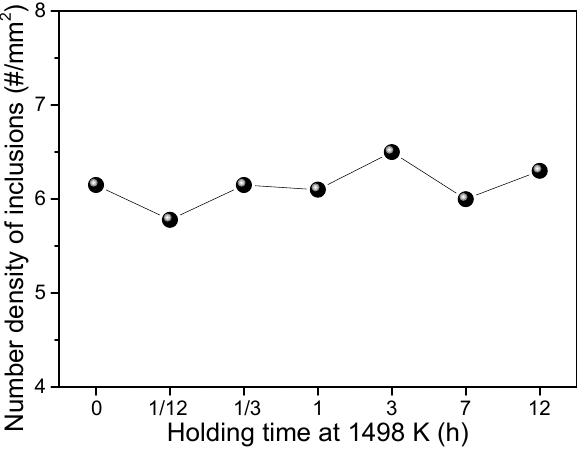
Figure 9. Variation in the number density of inclusions in the steel during heat treatment at 1498 K. The variation in the size distribution of the inclusions in the steel against the holding time is shown in Figure 11. The number of small inclusions increased after heat treatment at 1498 K,